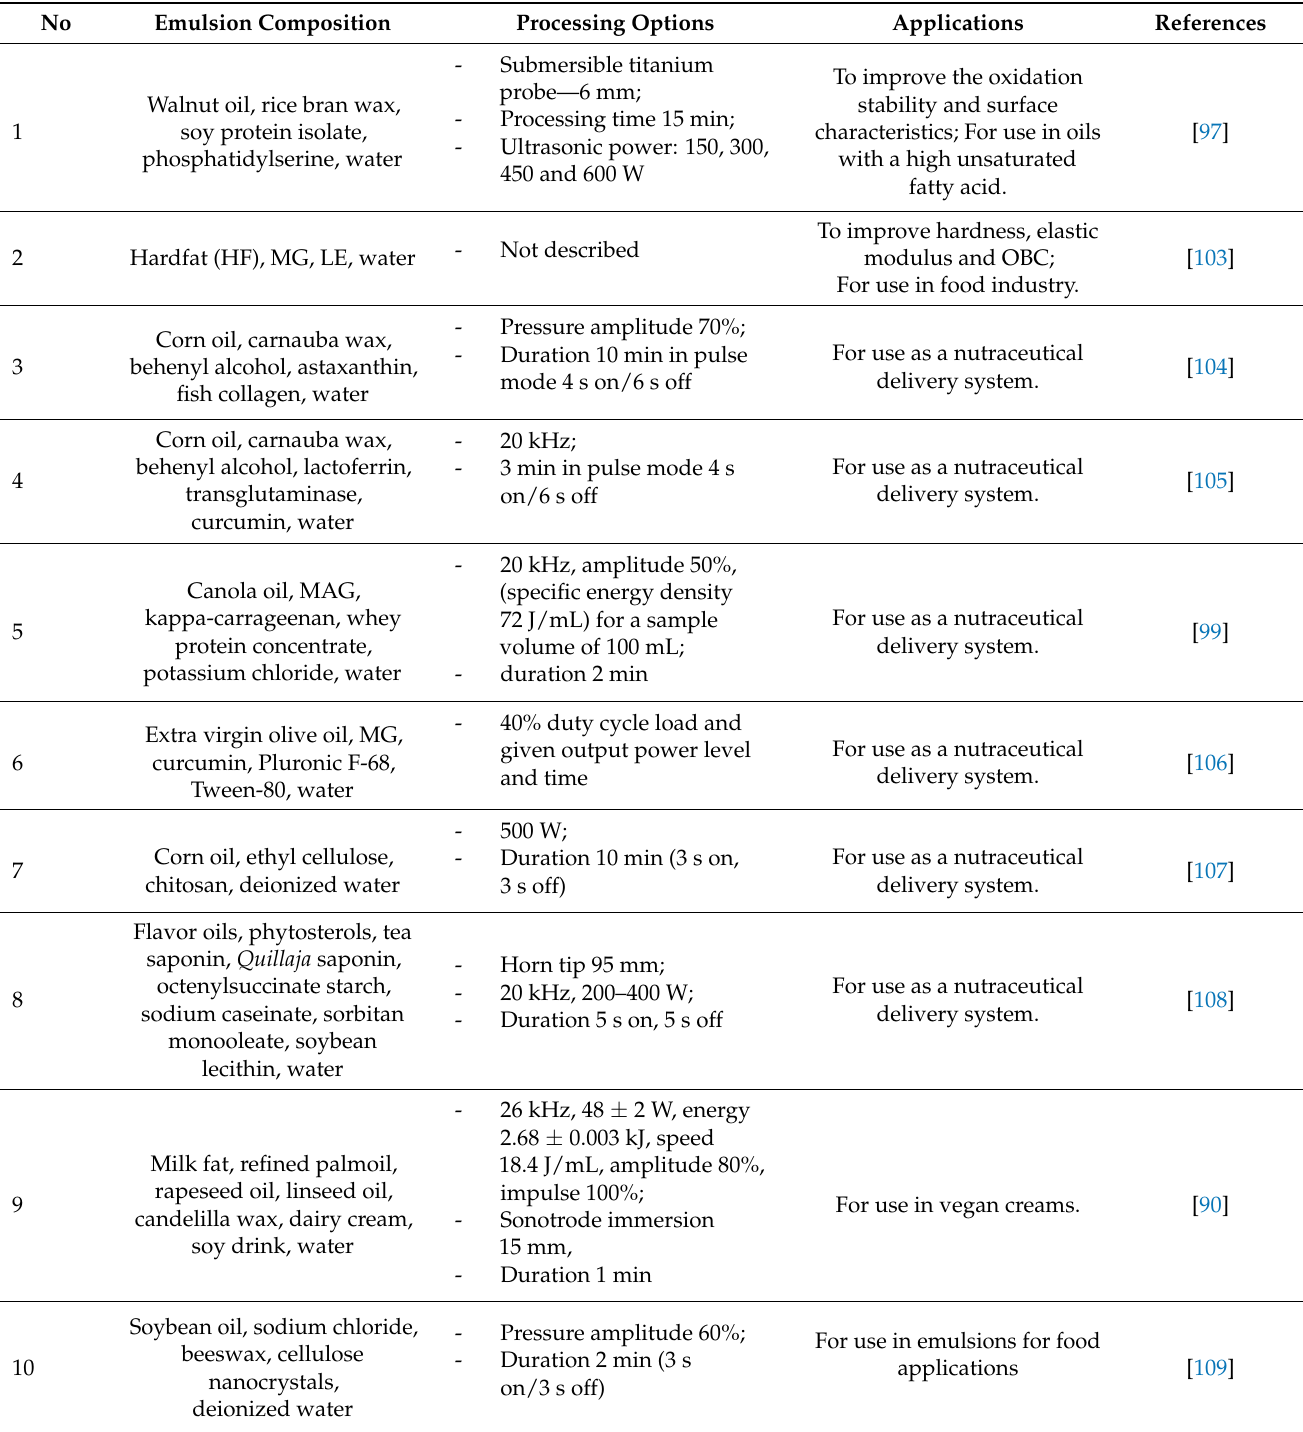
Table 2. Application of ultrasonic treatment for obtaining emulsion systems containing